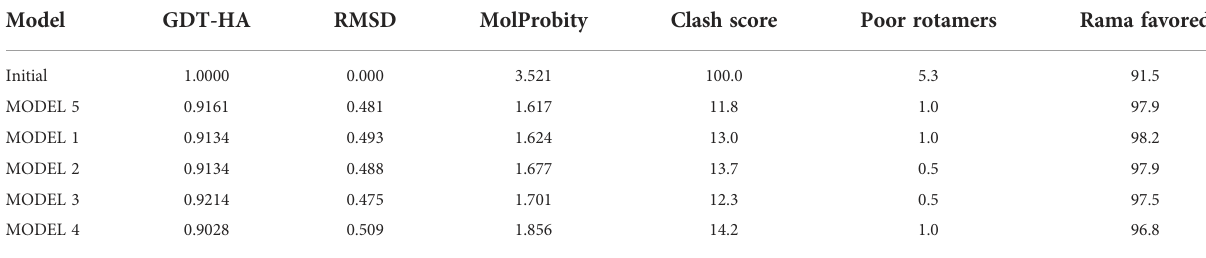
TABLE 3 The model parameters re fi ned by the Galaxy WEB server.